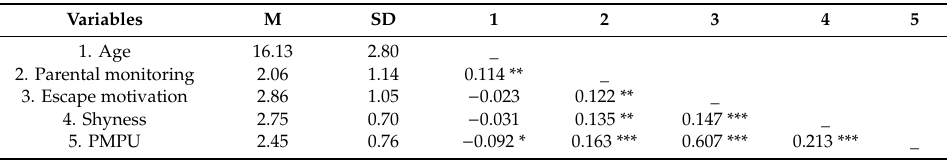
Table 1. Means, standard deviations, and correlations between